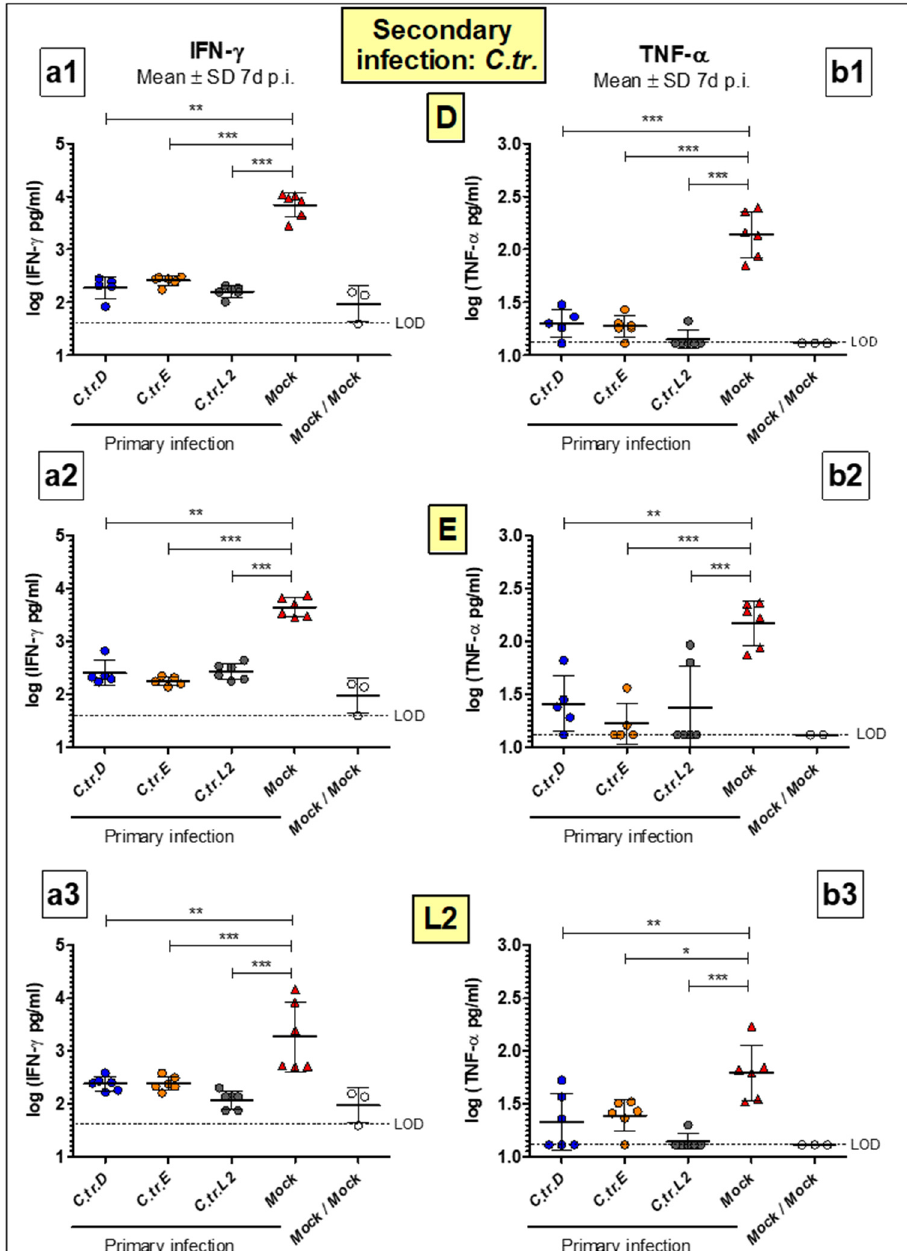
Figure 5. After recovery from a previous lung infection with either of the serovars, mice i.n. reinfected with C.tr. serovars D, E, and L2 similarly show lower IFN- γ and TNF- α concentrations in lung homogenate. Animals that were i.n. pre-challenged with C.tr. genital serovars D, E or L2 or mock material were infected again with the C.tr. serovars D (upper panels), E (middle panels) or L2 (lower panels) 7 weeks after the first infection. Mice twice infected with mock material served as negative control. Seven days after the second i.n. infection with C.tr. serovars D, E or L2, mice were painlessly sacrificed and IFN- γ (panels ( a1 – a3 ), mean ± SD of log 10 (IFU)) and TNF- α (panels ( b1 – b3 ), mean ± SD of log 10 (IFU)) levels were determined in lung homogenate. LOD: Limit of detection. The performed statistical analysis is described in Section 2. Group sizes were n = 5–6 with the exception of n = 2–3 for Mock/Mock. *–*** indicates statistical significances between the initially mock-infected (red) animal groups and groups previously infected with C.tr. D, E or L2 with p < 0.05, <0.01, and <0.001, respectively.